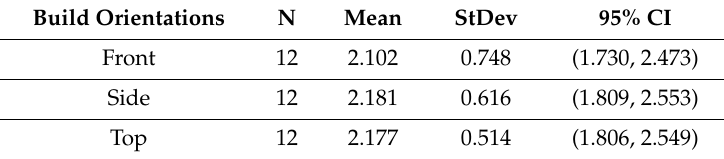
Table 28. Mean, standard deviation, confidence interval for Ra as a function of build